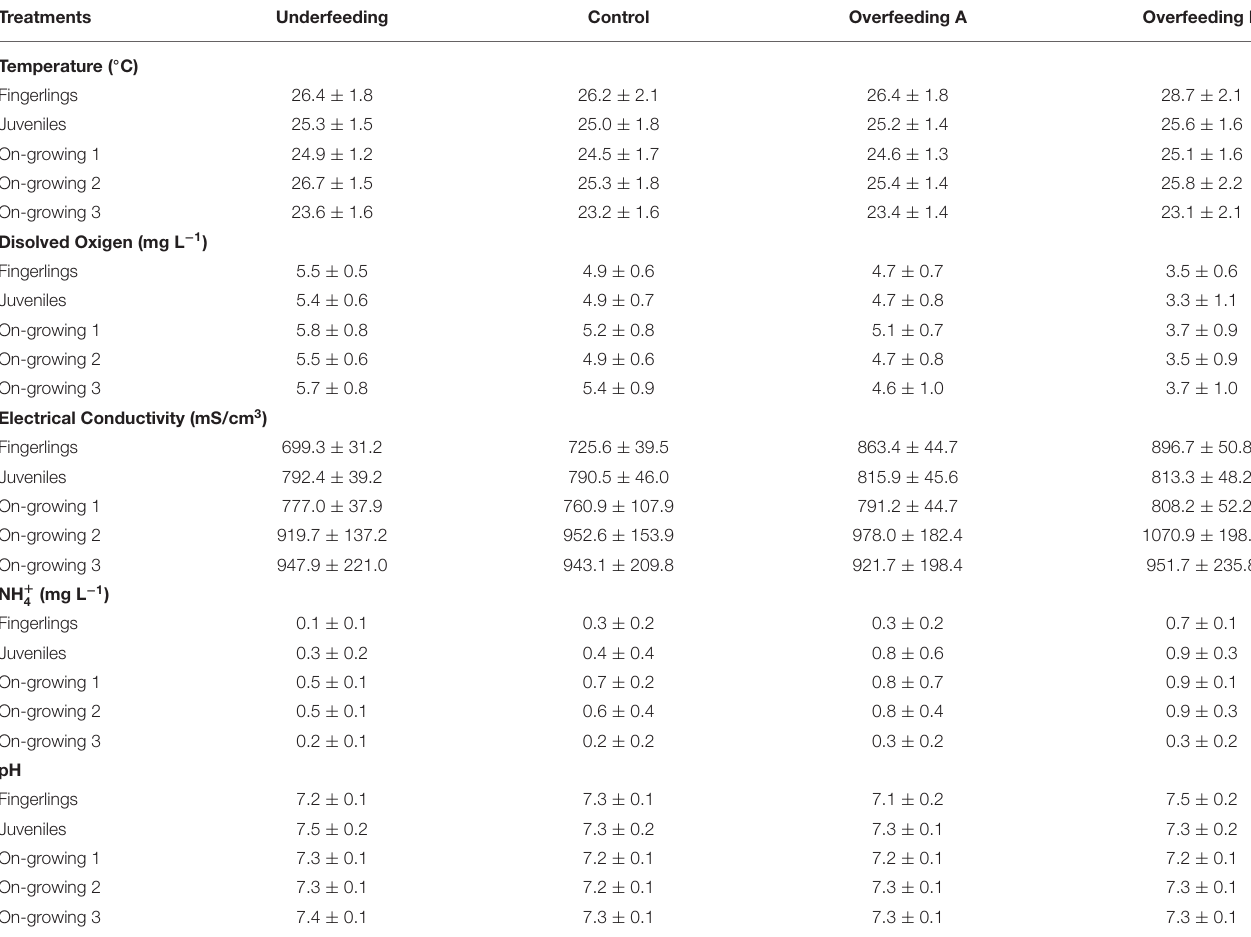
TABLE 9 | Water quality values during the